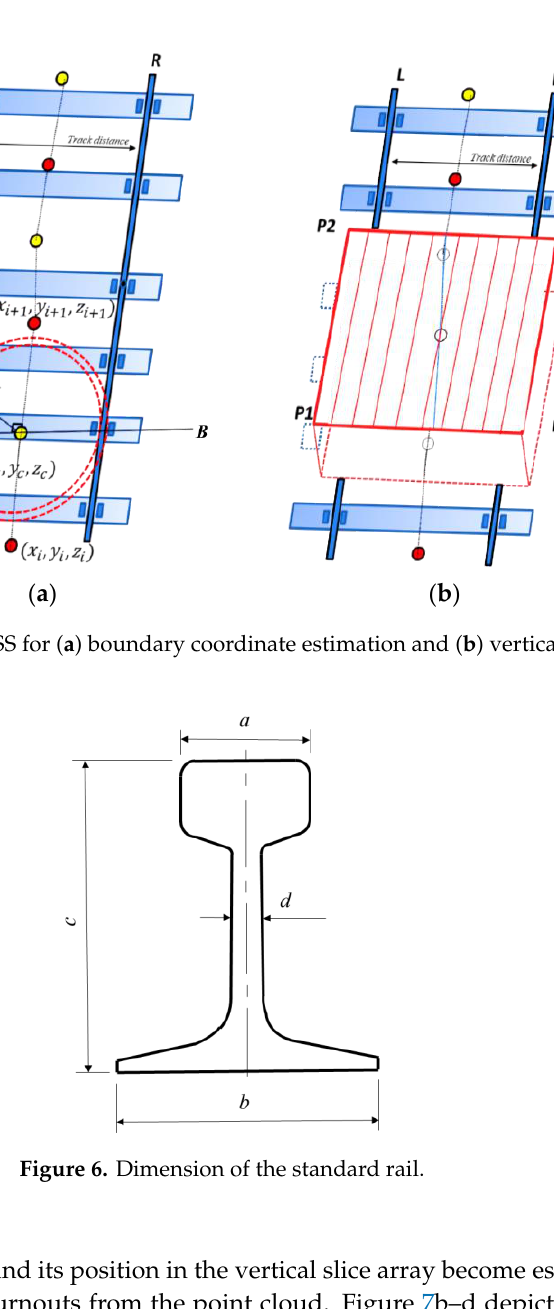
( c ) ( d ) Figure 7. Proposed vertical slice for point density extraction near to the railway: ( a ) ideal track ( b ) beginning of the track turnout ( c ) passing of the track turnout ( d ) the level crossing. 2.4. Structure Detection The point density value and its position in the vertical slice array become essential factors while detecting the crossings and turnouts from the point cloud. Figure 7b–d depicts an example of the turnout and crossing formation in vertical slices. We used that information with the following pattern detection methods to identify the structures and to measure their lengths. In the proposed method for crossing detection in Equation (1), vertical slices were formatted in liner 2D coordinates; where i is the slice iteration along the track and j is the slice iteration in the cross-track direction. S i,j denotes the point density of vertical slice. Then the point density variation was examined in each consecutive iteration captured by a 1 m interval. Near to the railway crossing, both vertical slices in the i th and j th